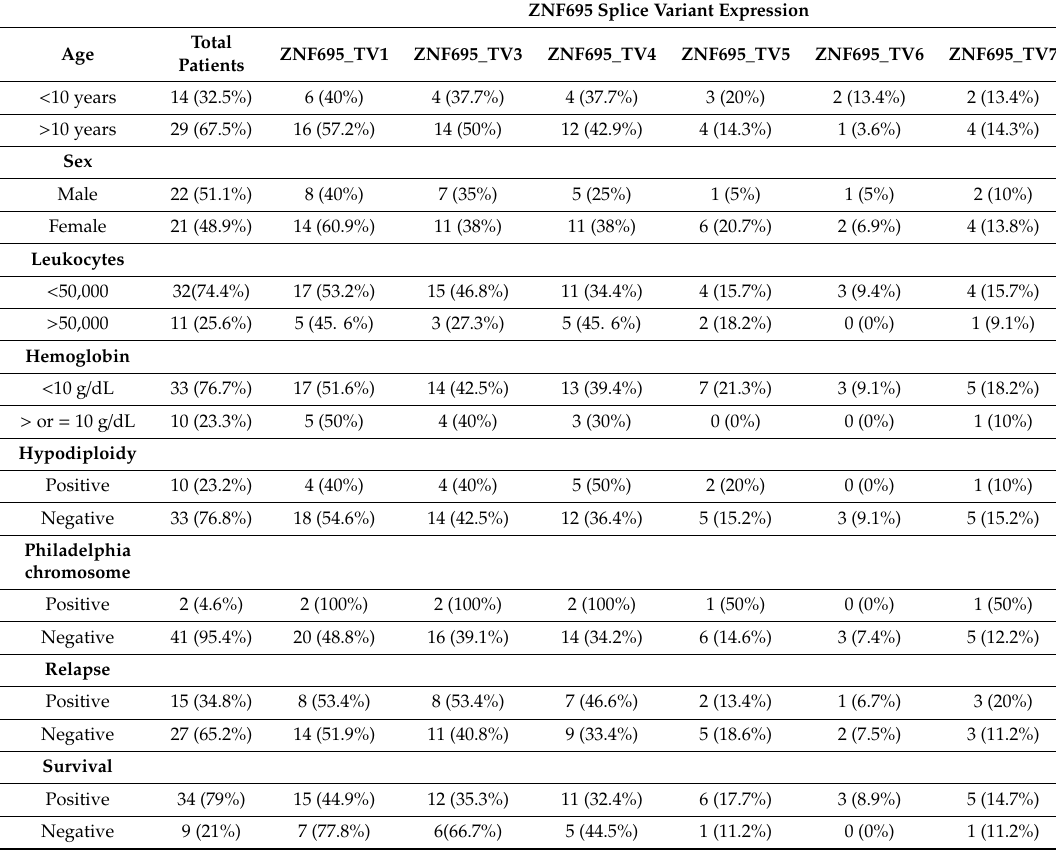
Table 2. Distribution of ZNF695 transcript variant expression in B-cell acute lymphoblastic leukemia (B-ALL) patients according to clinicopathological